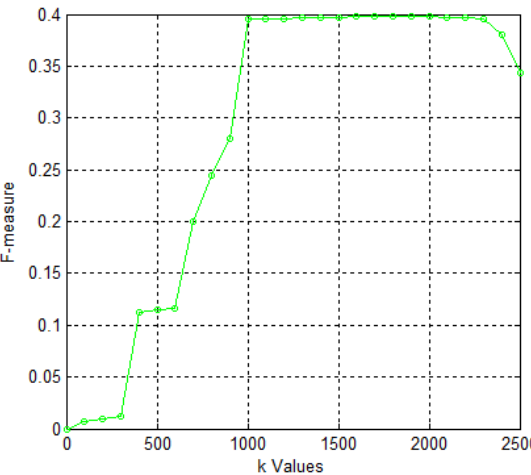
Figure 1. Values of F-measure for different values of k ∈ (0, 2500] with a 100 increment in HPRD dataset.